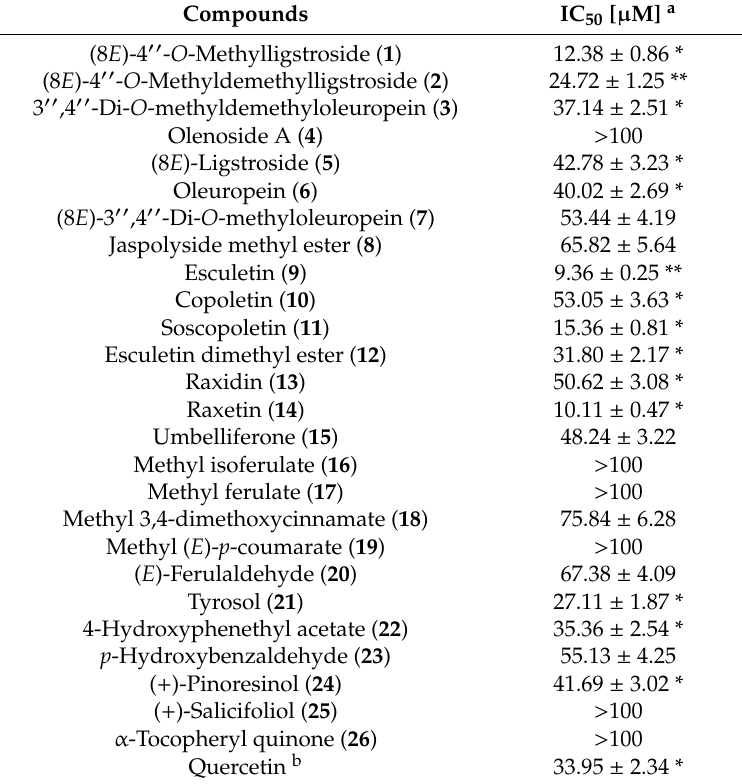
Table 4. Inhibitory e ff ects of compounds 1 – 26 from the stem bark of F . chinensis on nitric oxide (NO) generation by RAW264.7 murine macrophages in response to lipopolysaccharide